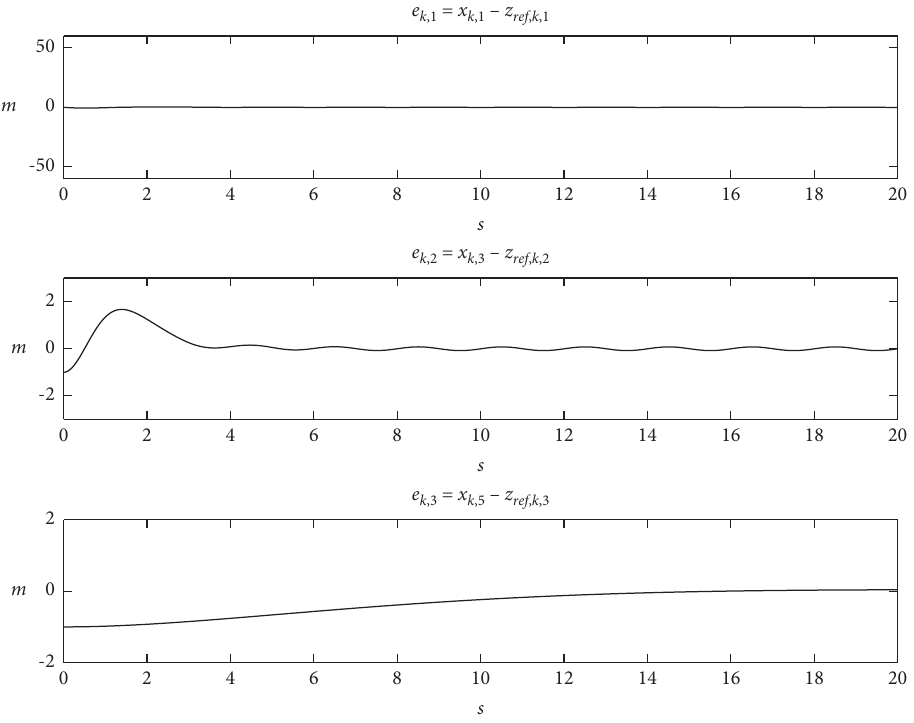
Figure 4: Tracking errors with minimum